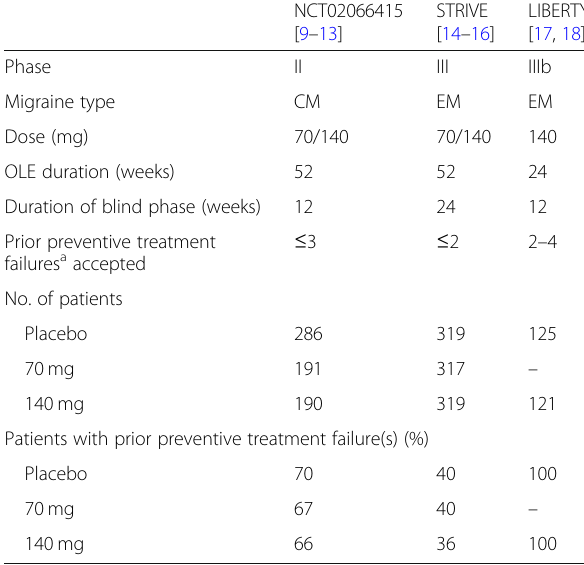
Table 1 Characteristics of the randomized controlled trials assessing the effect of prior preventive treatment failures on the treatment with erenumab for migraine